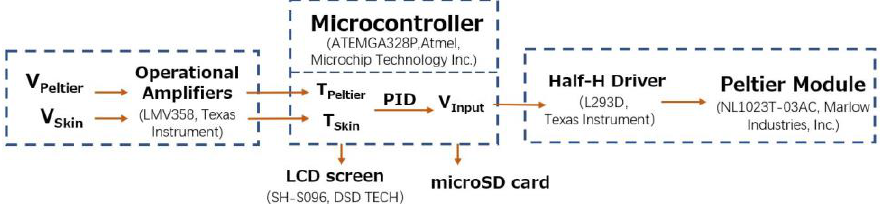
Figure 2. Block diagram of the control